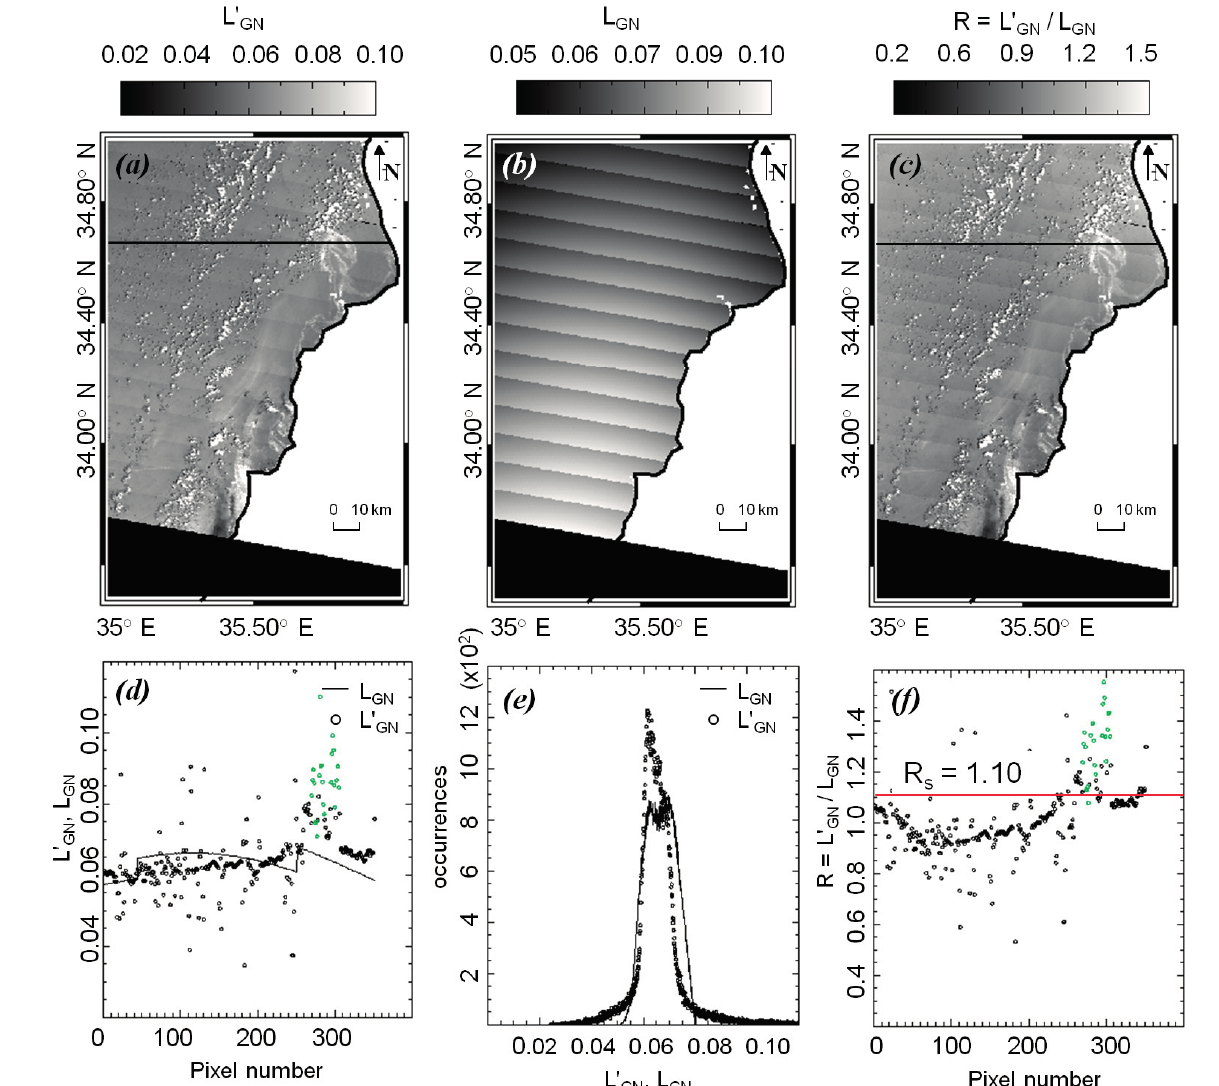
Figure 2. ( a ) MODIS-derived L' GN (bias-corrected), relative to Scene 2 of Table 1 (Lebanon coast, positive oil spill-water contrast); ( b ) L GN from Cox and Munk; ( c ) R = L' GN / L GN ; ( d ) comparison between L GN (solid line: Cox and Munk (1954) isotropic) and L' GN (dotted line) along the transect (black line in (a)). Green dots denote the oil spill pixels in the corresponding ROI; ( e ) L GN and L' GN histograms; ( f ) R values along the transect (black line in (c)) with green dots for oil spill pixels. The solid red line represents the oil spill separation index value R s from Table